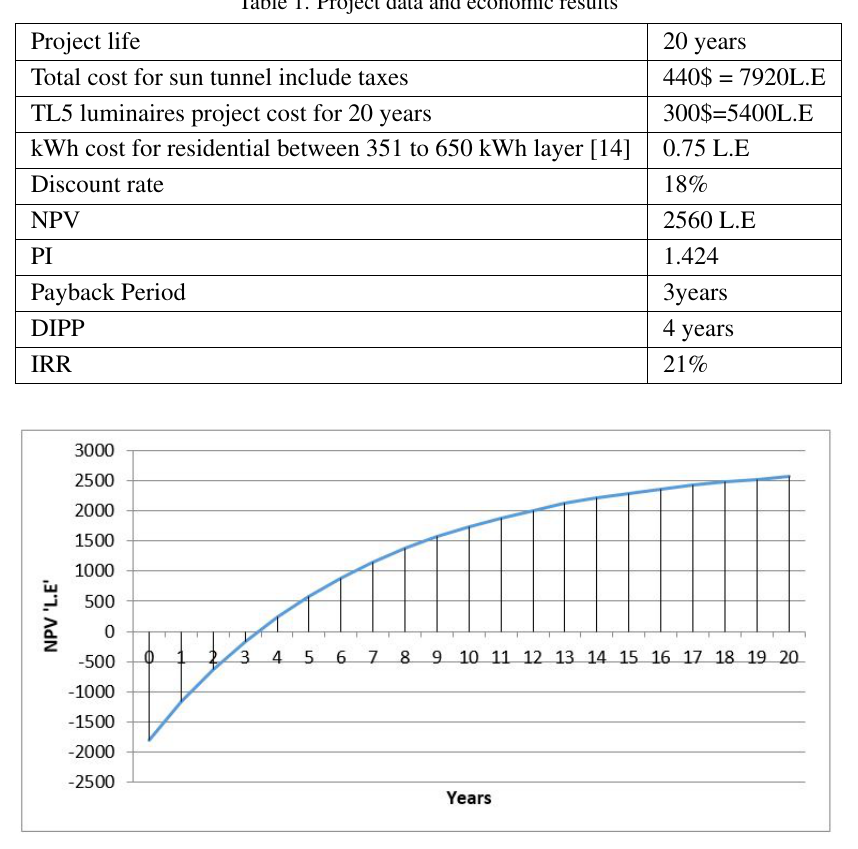
Figure 5. NPV over 20 years project